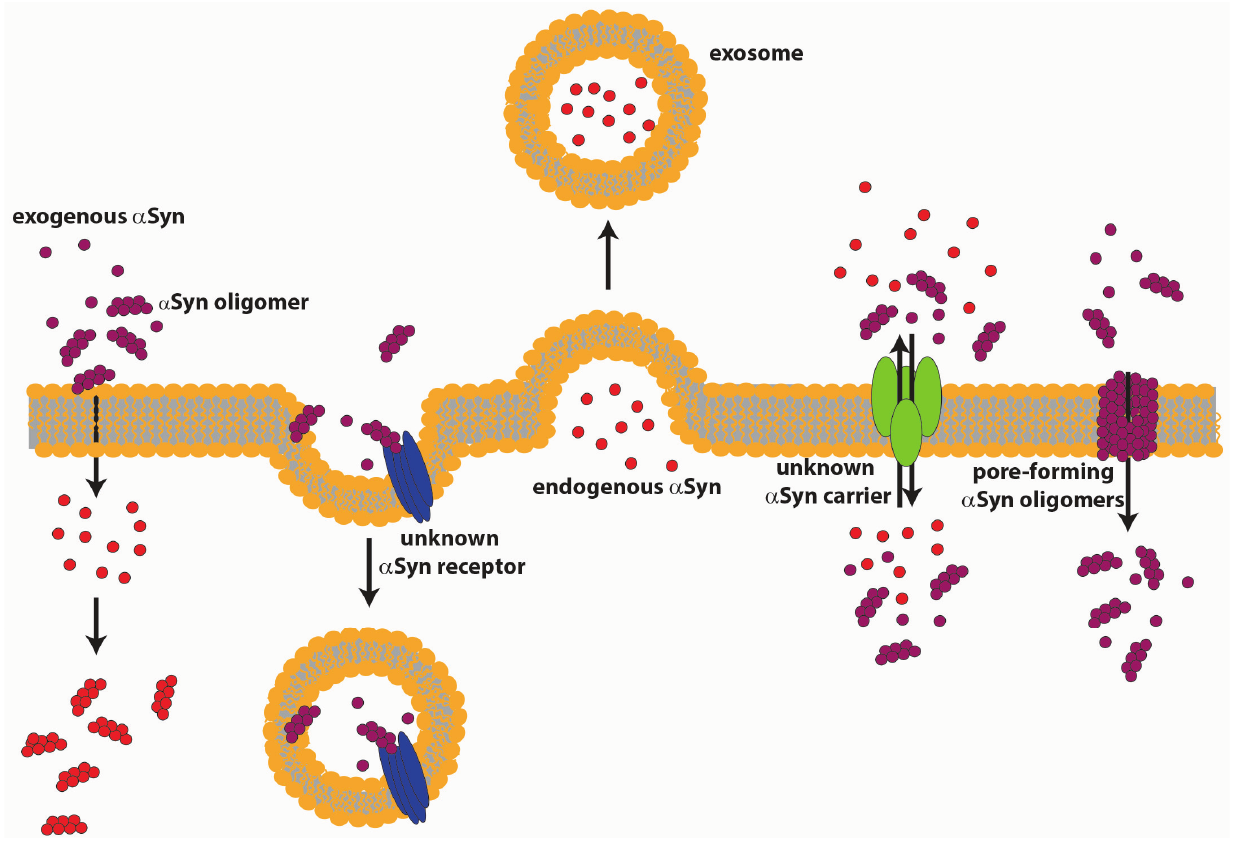
Figure 2. Mechanisms of (cid:2)Syn release and internalization. (cid:2)Syn can be released from healthy neurons by conventional exocytosis of vesicles or MVB, or through exosomes, or can pass the membrane with the help of an unknown carrier. (cid:2)Syn can enter neurons by internalization in vesicles, or through pores formed into the membrane by (cid:2)Syn oligomers, or by direct translocation across the plasma